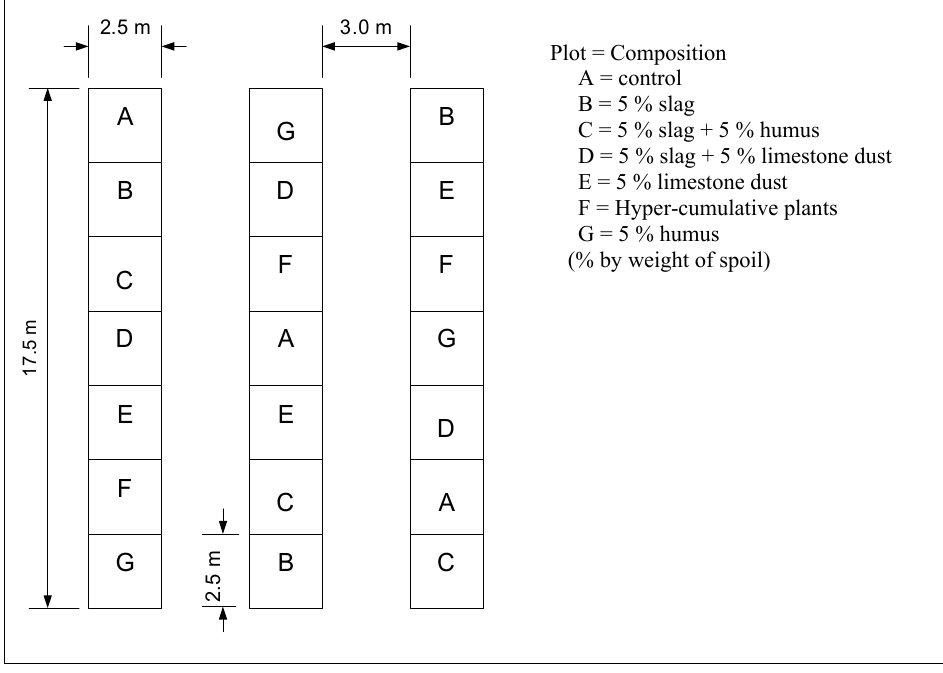
Fig. 8. Layout of plots of different mixes at Car